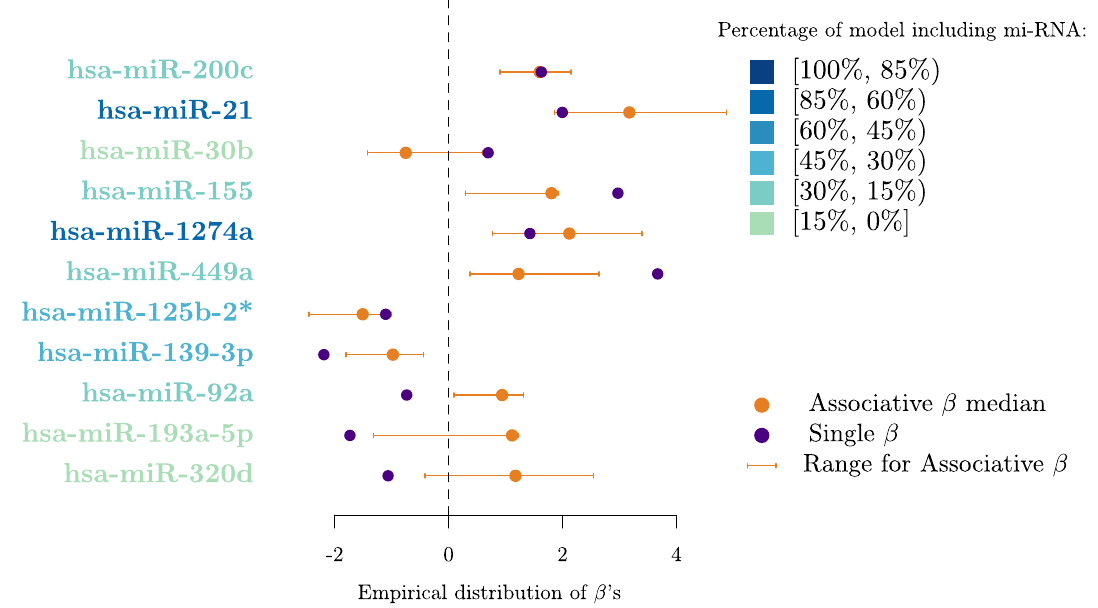
Figure 7. Distribution of β coefficients for the most frequently selected miRNAs. We present the single effect (i.e. the estimated value of a β coefficient when considering a single miRNA in the logistic model), the median and range of the associative effect (i.e. the different values that a miRNA specific β coefficient takes in each of the SWAG models in which it is present) for each of the most frequently selected miRNAs displayed in both Tables 3 and The case of hsa-miR-92a that displays discordant single and associative coefficients is not isolated. Among the miRNAs selected in at least 10% of the models, three show a similar behaviour to that of hsa-miR-92a : hsa-miR-320d , hsa-miR-193a-5p and hsa-miR-30b . Using a bioinformatics-based interaction analy- sis of hsa-miR-92a-3p and key genes in tamoxifen-resistant BC cells, Cun et al. 39 found that hsa-miR- 92a-3p was higher in BC serum or tissue than in healthy volunteer serum or adjacent normal tissue. Hence, a high expression of hsa-miR-92a-3p seems to predict poor prognosis for BC patients according to this meta-analysis study which has been recently validated by Jinghua et al. 40 . These findings are in contradiction with previous results published by Nilsson et al. 41 that suggest that downregulation of hsa-miR-92a-3p is associated with aggressive BC features and increased tumour macrophage infiltration. In relation to hsa- 42 found that its downregulation favours BC progression. To the best of miR-320d action in BC, Cava et al. our knowledge, no other study has investigated the role of hsa-miR-320d in BC progression, therefore it is not possible to compare our result with other data coming from recent literature. According to Maltseva et al. 43 , hsa-miR-193a-5p is less expressed in inflammatory BC patients and is known to play a suppressive role in BC. This statement is in contradiction with the findings in Li et al. 44 that state that long non-coding RNA small nucleolar RNA host gene 1 (SNG1) activates the HOXA1 expression via sponging hsa-miR-193a-5p in BC progression. Finally, the role of hsa-miR-30b has been shown to be versatile, as a recent review points out 45 . Members of the hsa-miR-30 family play a role in the regulation of tumorigenesis, interference with tumour invasion and metastasis, as well as reversal of drug resistance. Nevertheless, some hsa-miR-30 family members have independent protective effects on the prognosis of BC patients. Surprisingly, among the patients of the AHUS dataset, hsa-miR-200c is oncogenic in 100% of the cases, with single and associative β coef- ficients remaining always positive. Therefore, hsa-miR-200c cannot be qualified as antagonistic within our study. However, this finding is in contradiction with previously published research, where hsa-miR-200c is known to be tumor suppressing in BC 46,47 . Song et al. found that hsa-miR-200c inhibits the AKT and ERK pathways by directly targeting KRAS. Repression of KRAS by hsa-miR-200c suppressed the proliferation and survival of BC cells in vitro and in vivo. It is therefore surprising that our results are in contradiction with well-established evidence. In order to understand this paradoxical result, we have drawn the hsa-mir-200c network from the AHUS data set (cf Fig. 8). One can notice that the miRNAs most commonly associated with hsa-miR-200c in our study are hsa-miR-449a (frequency of association with hsa-miR-200c : 100%), hsa-miR-125b-2* (frequency of association: 94%), and hsa-miR-155 (frequency of association: 89 %). These four miRNAs seem therefore to act together, particularly hsa-miR-200c and hsa-miR-449 that form a twin pair. Interestingly, there is no research in the recent literature linking these two miRNAs in BC. The association of hsa-miR-200c and hsa-miR-125b has been studied in a recent work where no significant correlation between these two miRNAs was observed 48 . The hypothesis that we put forward to explain our counter-intuitive result is that in this cohort, the oncogenic function of hsa-miR-200c is stabilized by its high connection with hsa-miR-449a . However this hypothesis needs to be investigated through further research.